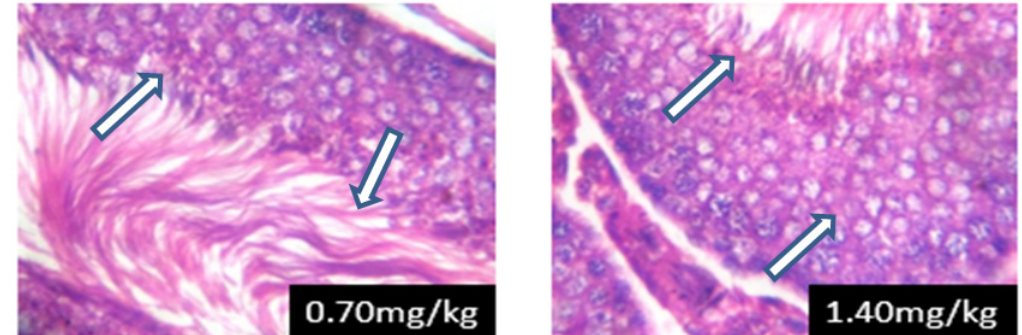
FIGURE 5 – Photomicrograph of the histology of the seminiferous tubules of control and treated rats. H & E X 400 magnification.